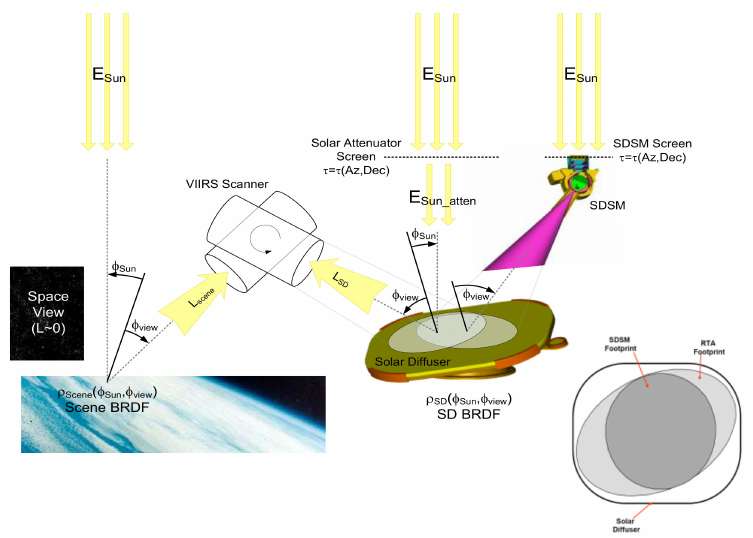
Figure 2. Diagram of the VIIRS solar diffuser calibration. This includes the VIIRS scanner that looks at the Earth and solar diffuser ( SD ) when illuminated by the Sun through an attenuation screen and the solar diffuser stability monitor (SDSM) that views the Sun through a screen and the SD while it is